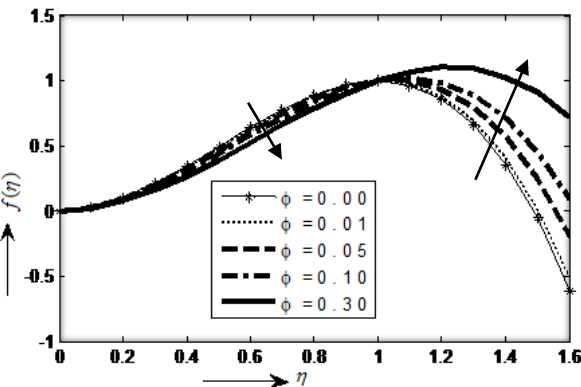
Figure 13. Variation of fluid velocity f (  ) against  for slip coefficients  (0.0, 0.01, 0.05, 0.10, 0.30) by taking parameters M =0, K = 0 and Re = 0.3